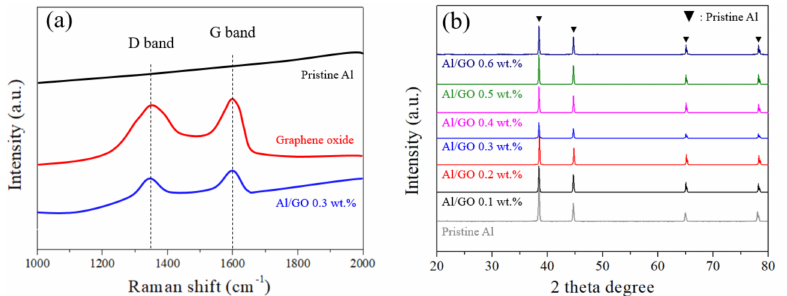
Figure 3. Comparison of ( a ) Raman spectra of bare Al, GO and Al / GO 0.3wt.% powder and ( b ) XRD patterns of sintered Al / GO composites for verity of GO